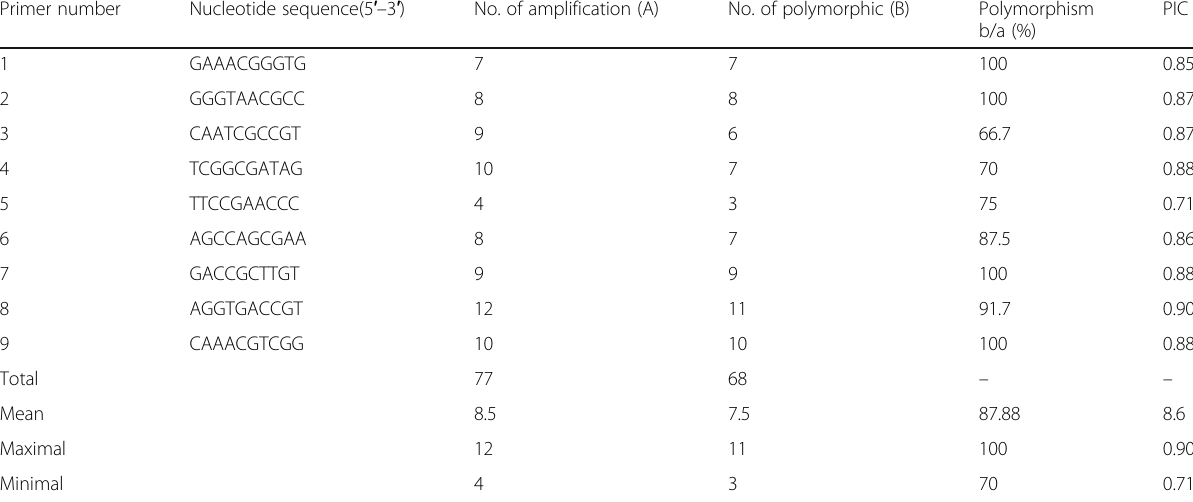
Table 3 Number of amplification and polymorphic products using nine primers in rice cultivars and their somaclons Primer number Nucleotide sequence(5 ′– 3 ′